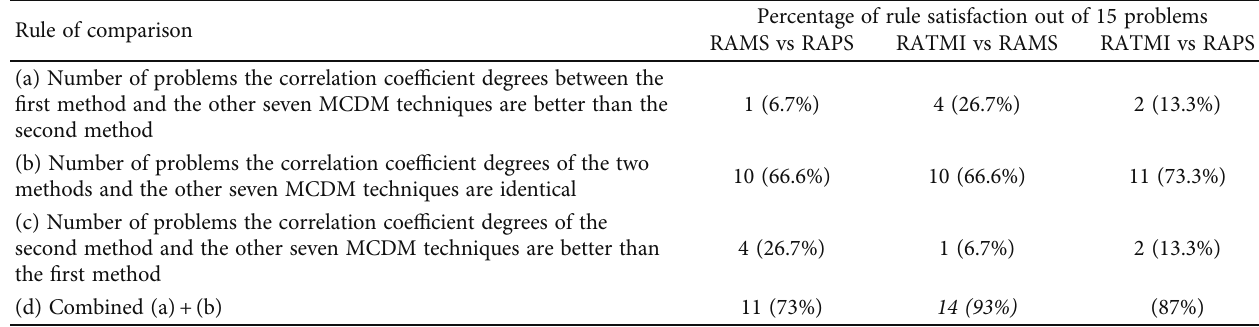
Table 14: Comparative percentage between the three methods RAPS, RAMS, and